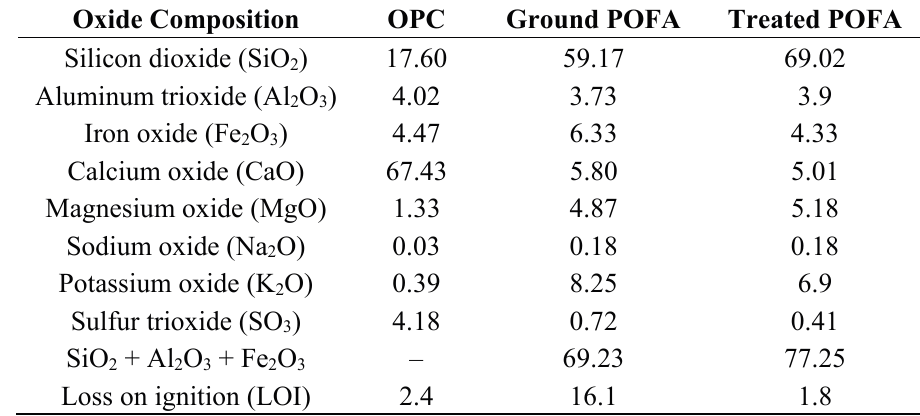
Table 2. Chemical compositions of OPC, ground POFA, and POFA